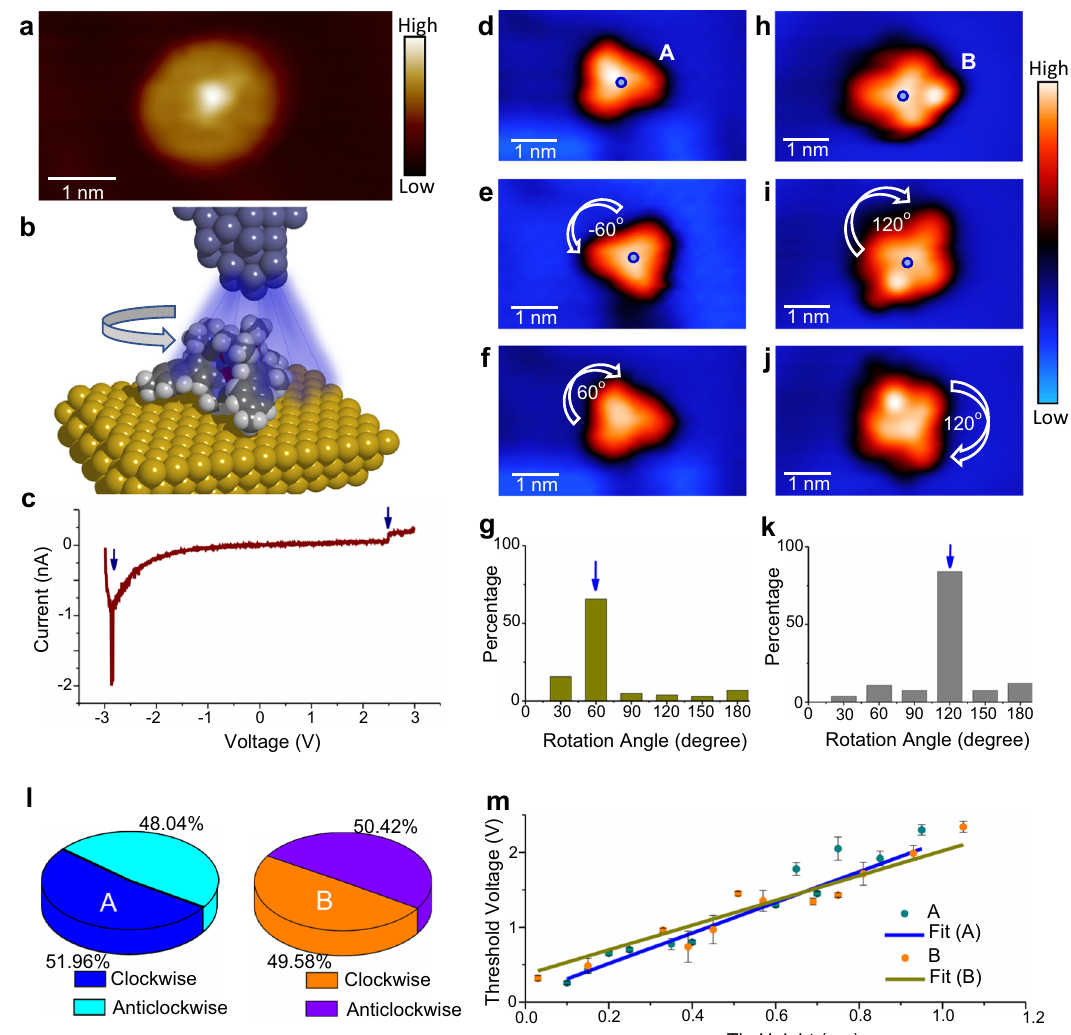
Fig. 4 | Electric fi eld induced rotations. a An STM acquired at 100K shows a rotating complex [V t = − 1.5V, I t =3.0×10 − 11 A]. b Illustration of the STM tip induced electric fi eld rotation process. c AnI – V spectrum acquired above a complex reveal sudden changes in current (indicated with arrows) due to rotations. Complex [Eu(pcam) 3 X] 2+ (labelled “ A ” ) in ( d ) is rotated anticlockwise by 60° ( e ) and then clockwise by 60° ( f ) [V t = − 2.0V, I t =3.5×10 − 11 A, 5K]. g The rotation angle dis- tribution plot shows 60° as the key rotation angle. Complex [Eu(pcam) 3 X 2 ] +